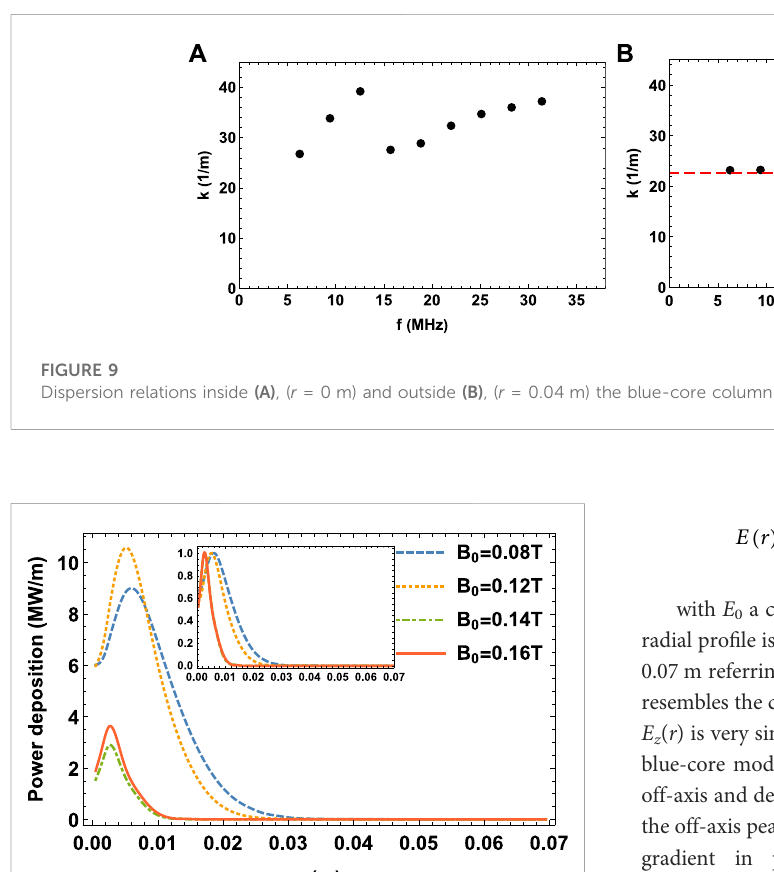
FIGURE 10 Integrated radial pro fi les of power deposition for the four external magnetic fi eld strengths. The inset shows normalised